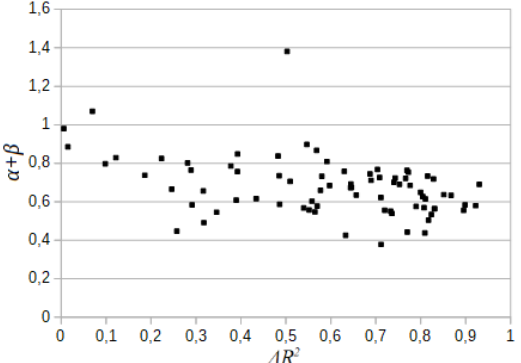
Fig. 7. Dependence of the returns to scale of model (1) on ΔR 2 for (4a) and (4b).